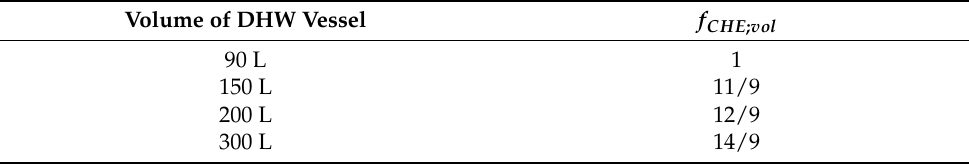
Table 1. Correction factor for sizing the internal coil heat exchanger of the DHW